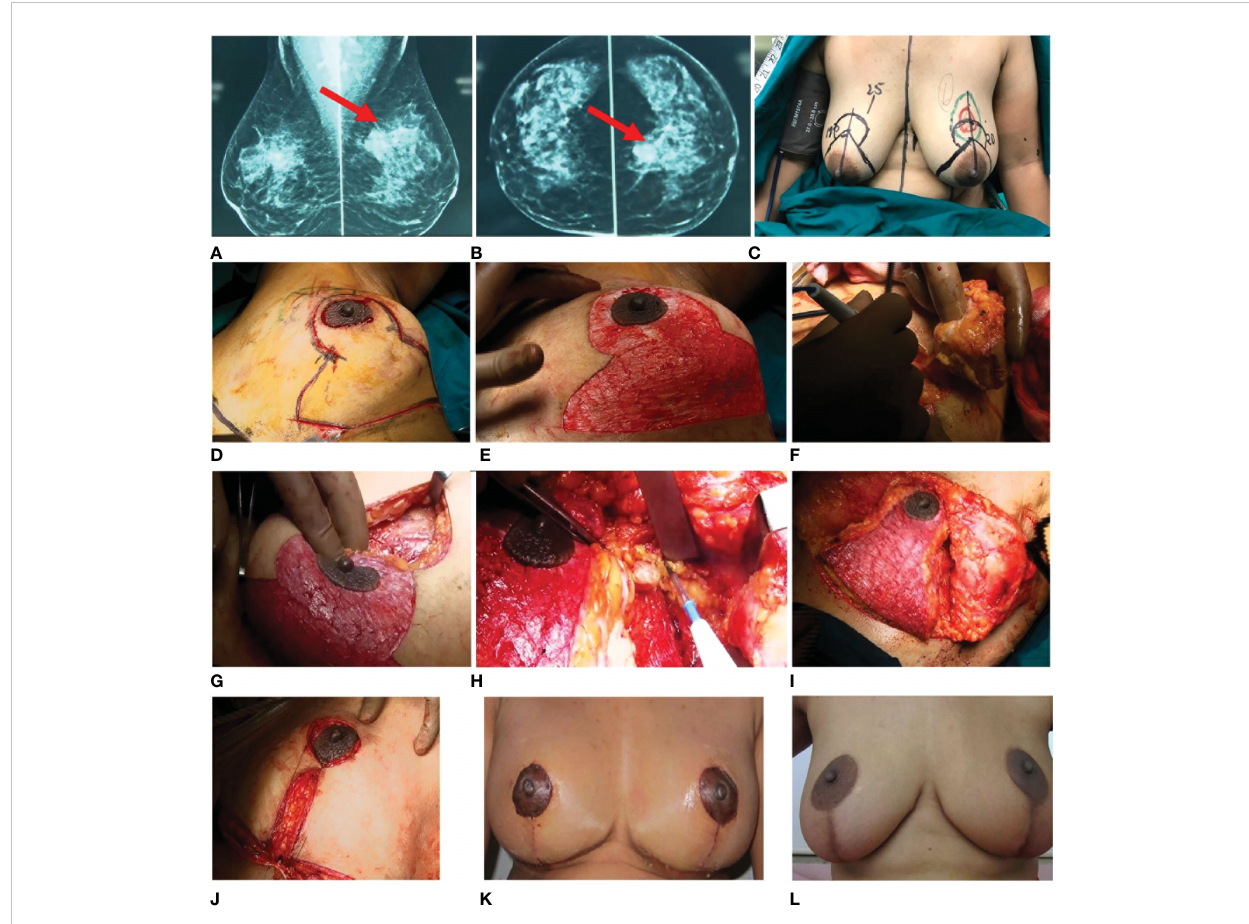
FIGURE 5 Simple TM. Pre-operative radiology images (A, B) show a partially circumscribed obscured iso- to hyperdense lesion seen in the upper central quadrant of the left breast. (C) Markings. (D – J) Intra-operative images. (D) Wise pattern incision marked. (E) De-epithelialized area. (F) Excision of the tumor. (G) Tumor bed. (H) Sentinel node biopsy. (I, J) Inferior pedicle is used to restructure the breast. (K, L) Post-operative images. (K) One-month follow-up. (L) Annual follow-up. TM, therapeutic